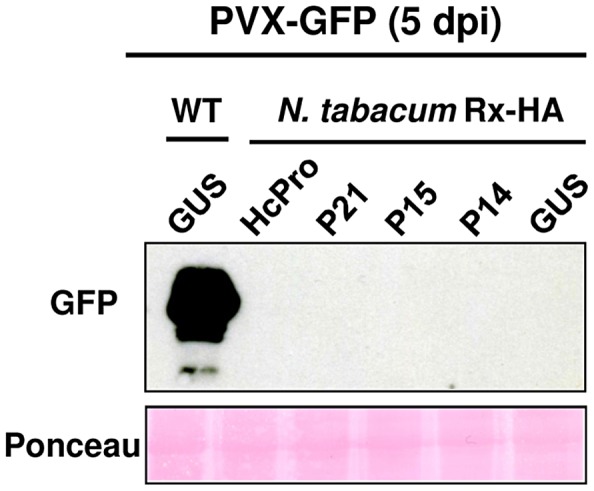
VSRs that bind small RNAs in vitro do not compromise resistance mediated by Rx against PVX.Leaves of five week-old N. tabacum expressing the Rx gene and its corresponding counterpart lacking this R gene was infiltrated with of A. tumefaciens strains expressing PVX-GFP together with a strain expressing P14, P15, P21, P25, HcPro or the GUS reporter gene. GFP accumulation in infiltrated leaves was detected by Western analysis using an anti-GFP antibody. Ponceau staining of the membrane is shown to demonstrate equal protein loading. Experiments were repeated three times and gave similar results.